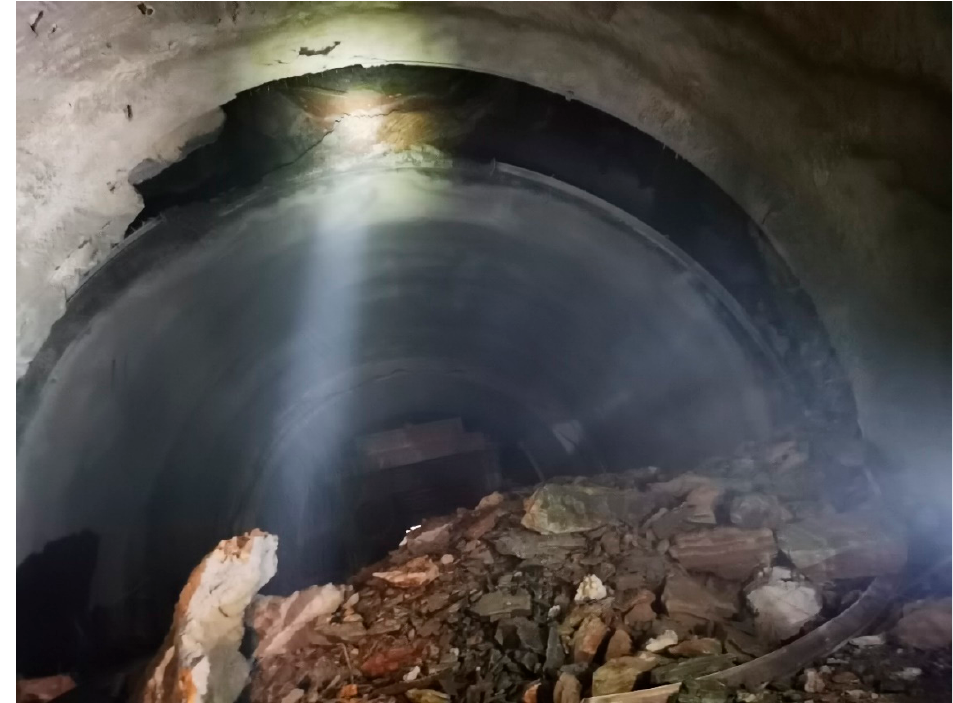
Figure 5. Collapse of tunnel primary support structure.